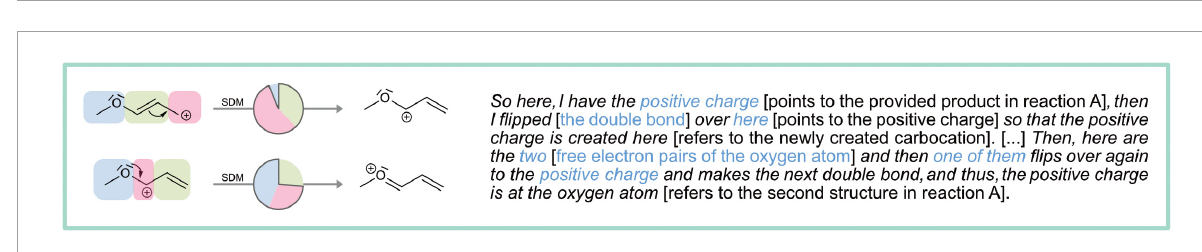
FIGURE13 Paula’s drawing moves, fixation duration rates on the structural features and drawing description for her drawings in reaction A. The green frame indicates the productivity of the resulting